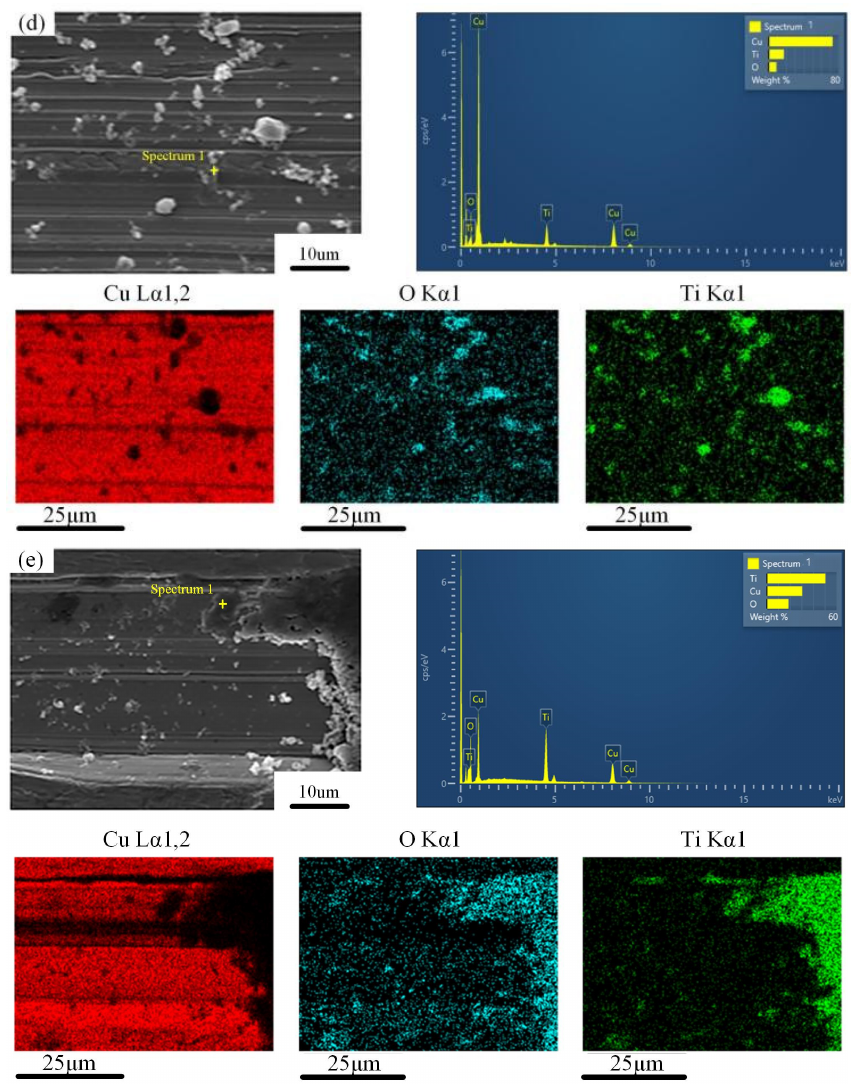
Figure 9. The SEM and EDS mappings of the rolled copper foils with different lubrication conditions: ( a ) 1.0 wt%, ( b ) 3.0 wt%, ( c ) 5.0 wt%, ( d ) 7.0 wt%, ( e ) 9.0 wt%.